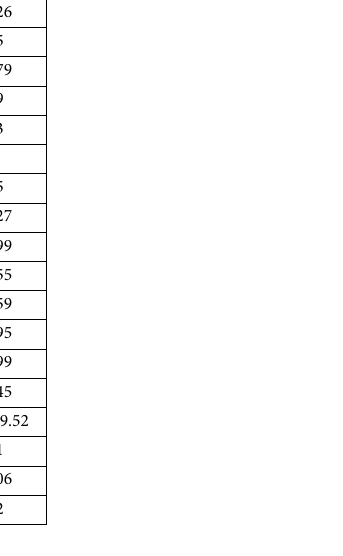
Table 2. Hematology results of the treated blood